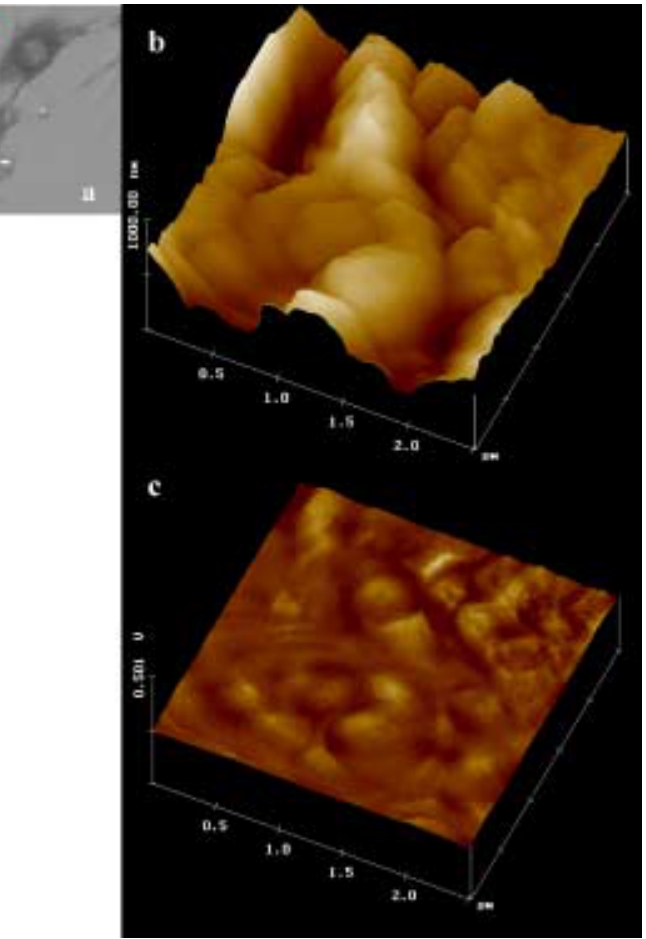
Fig. 4. (a) Far-field image of cells of the breast cancer cell line T-47D (after 48 hours treatment with 5 × 10 − 7 M E 2 ) detected with 40 × magnification; typical globular shape is visible. (b) Near-field topographic image of a cellular surface section of the breast cancer cell indicated in (a) by an arrow; strong furrows with a few rosettes only are visible; (c) near-field transmission light image of the same surface section. Regions of the rosettes do not always correspond to low absorbance